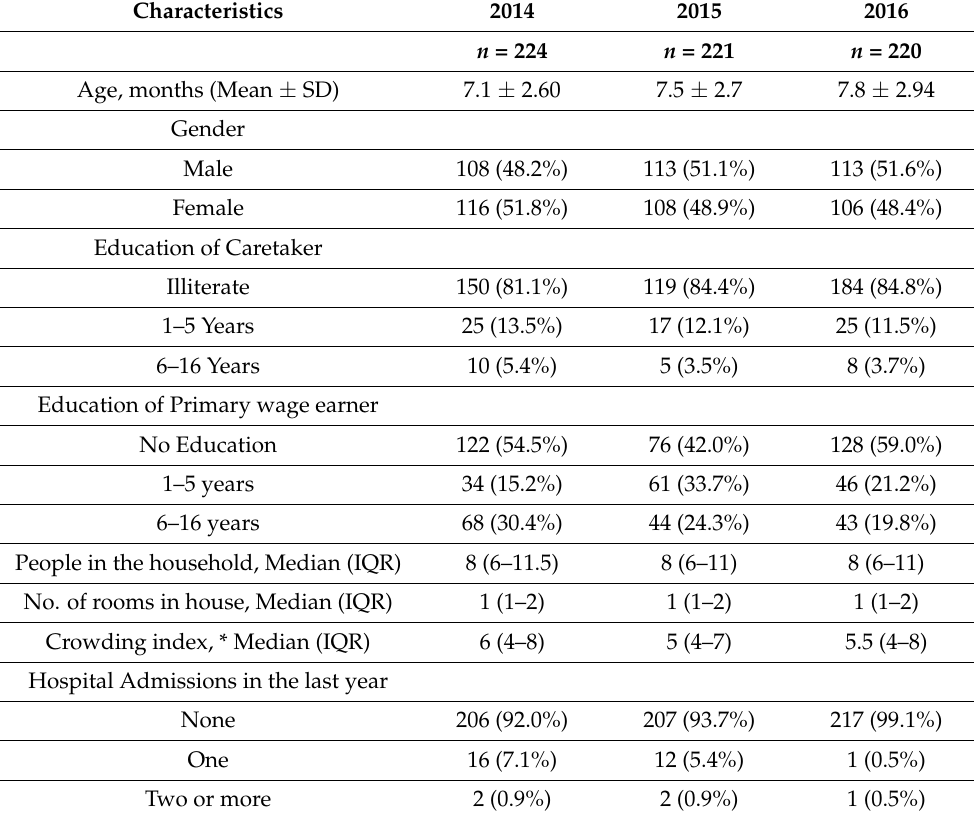
Table 1. Sociodemographic characteristics of enrolled